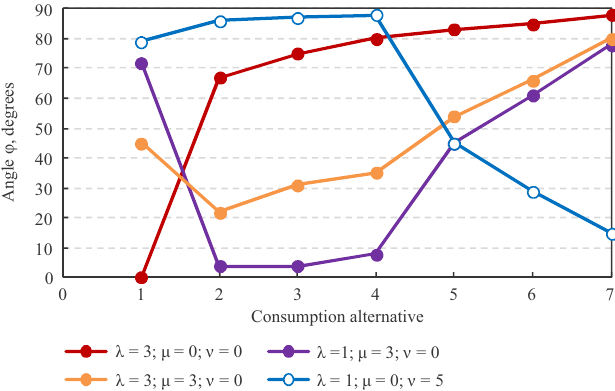
Fig. 3. Angle φ between consumer’s preference vector and the aggregate value vector of goods in